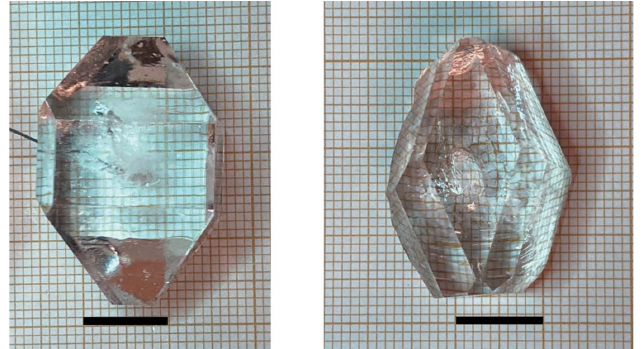
Figure 5 Large single crystals of xylitol (left) and erythritol (right). The scale bar represents 10